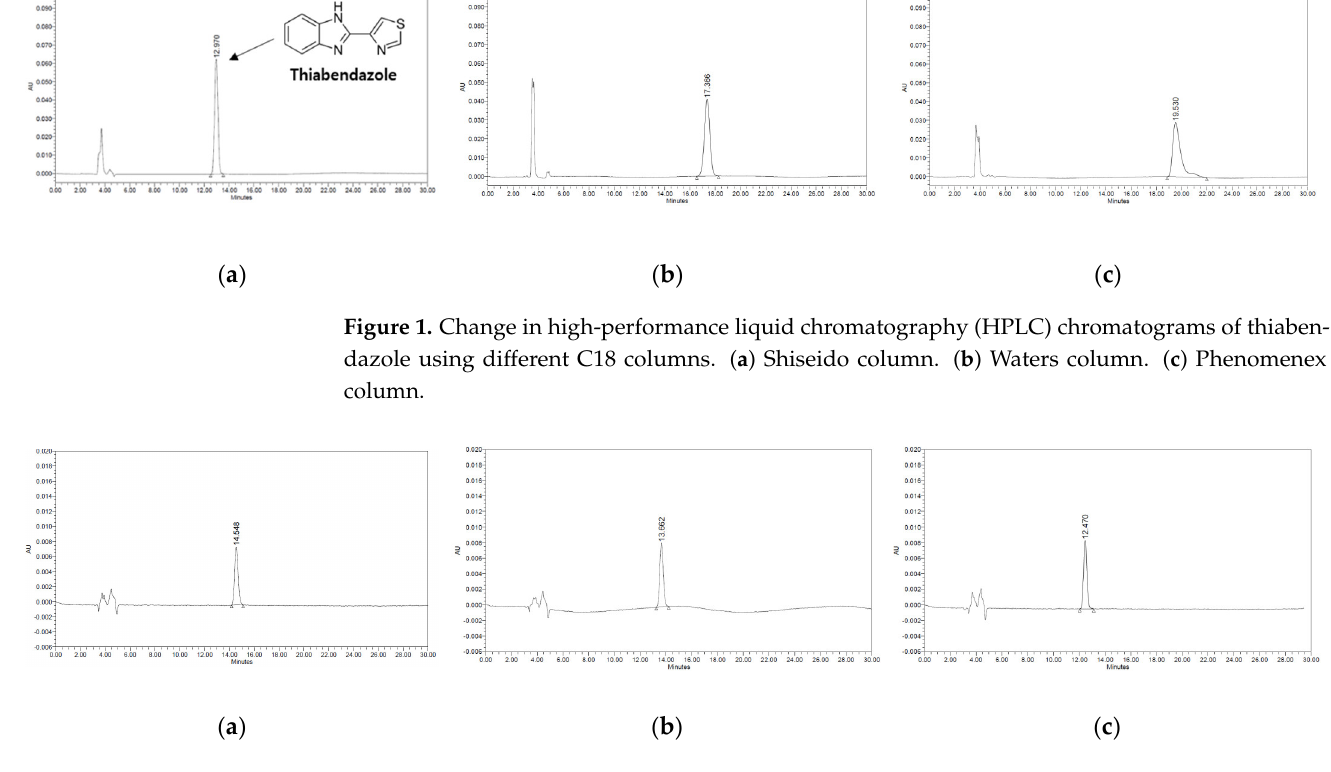
Figure 2. High-performance liquid chromatography (HPLC) chromatograms of thiabendazole according to different col- umn temperatures. ( a ) 20 °C. ( b ) 30 °C. ( c ) 40 °C.